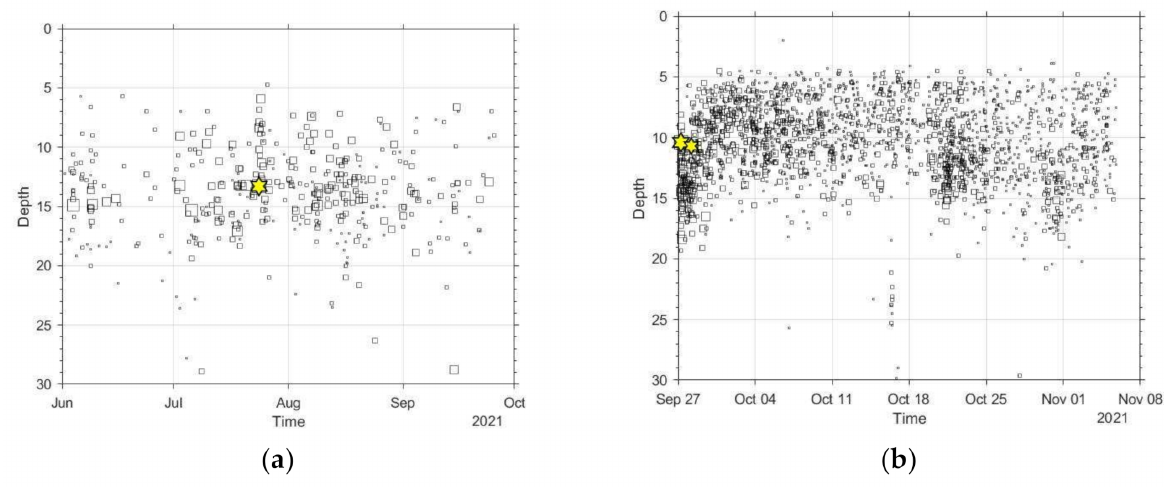
Figure 9. Focal depth versus time for foreshocks ( a ) and for aftershocks occurring up to 5 November 2021 ( b ). Stars show the largest foreshock of 24 July 2021 ( a ), as well as the main shock of 27 September 2021 and the largest aftershock of 28 September 2021 ( b ).